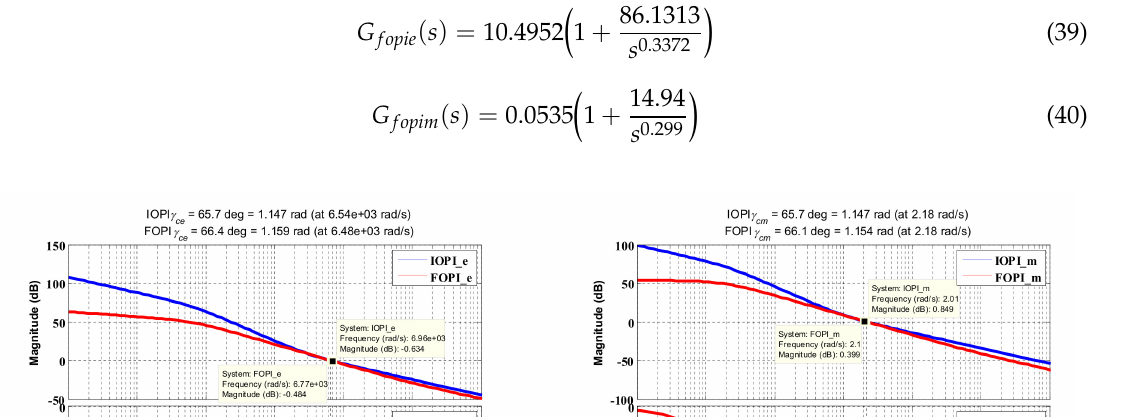
Figure 6. All the black lines indicate the response of FOPI controller; meanwhile, the red lines imply that of IOPI controller. The di ff erent styles of lines (solid line, dashed line, dotted line, and dash-dot line) represent the di ff erent settling